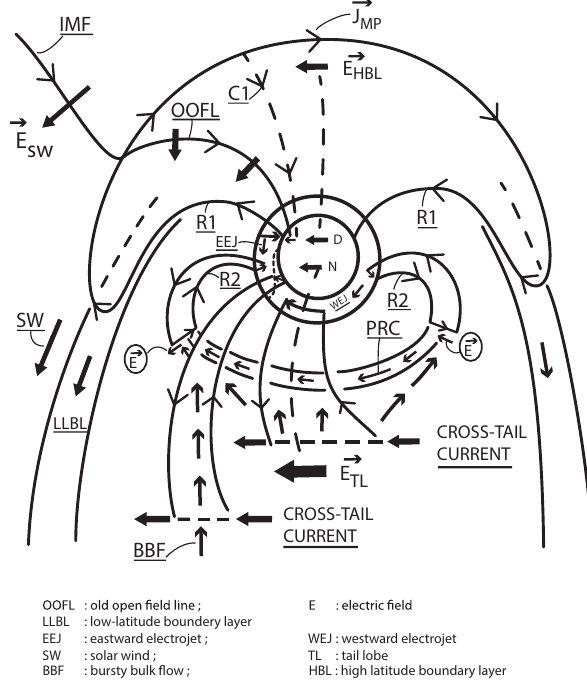
Fig. 13. Schematic illustration of Northern Hemisphere current sys- tems relating to the dayside and nightside sources of polar cap con- vection as marked by two dawn-to-dusk-directed E fields ( D and N ) in the polar cap. The dayside source consists of dynamo pro- cesses ( E · J < 0) in magnetospheric boundary layers (BLs) at high (HBL) and low (LLBL) latitudes. E -field coupling from the solar wind ( E SW ) (along old open field lines) to the polar cap in the postnoon sector is illustrated for a southwest-directed IMF ( B z < 0; B y < 0). Dayside R1 FACs connected to the low-latitude boundary layer (LLBL) and the magnetopause current flowing over the top of the magnetosphere ( J MP ) are shown. The substorm current systems are reproduced from Fig. 1. The auroral oval is represented by two concentric circles. The Harang reversal boundary is marked by a dashed curved line connecting the poleward and equatorward oval boundaries at dusk–premidnight. E -field coupling from the tail lobe ( E TL ) to the nightside polar cap ionosphere ( N ) is